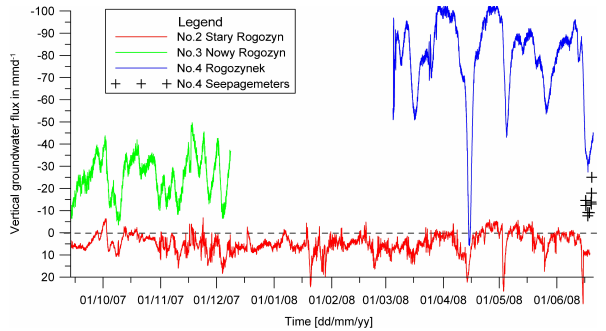
Fig. 10. Temporal distribution of the GSI in the riverbed of the Biebrza River based on time series of hydraulic head and hydraulic conductivity values derived with